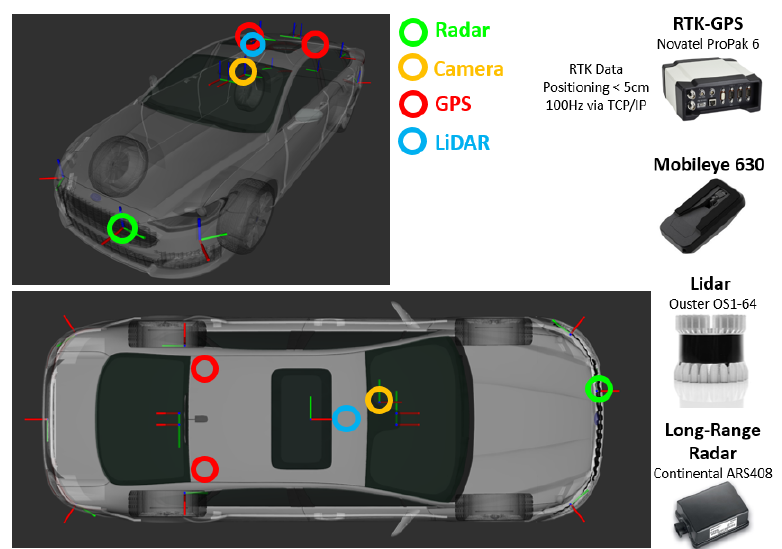
Figure 8. VIF’s ADD vehicle sensor setup and the corresponding mounting positions.